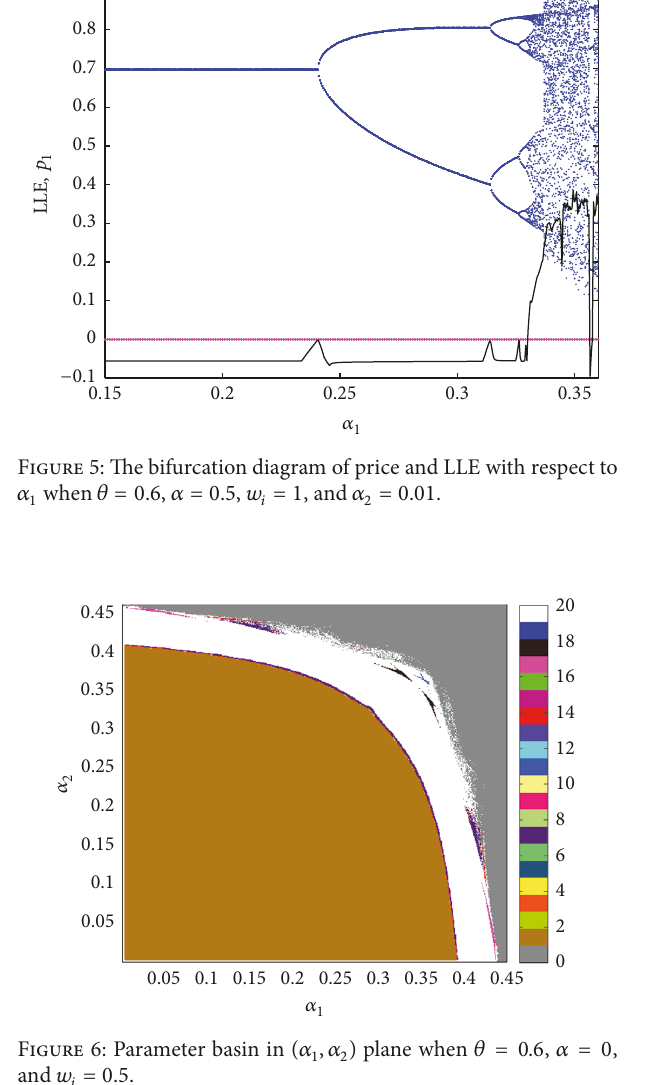
Figure 9: The average profits with respect to 𝛼 1 when 𝜃 = 0.5 , 𝑤 𝑖 = 0.5 , and 𝛼 = 0.25 2